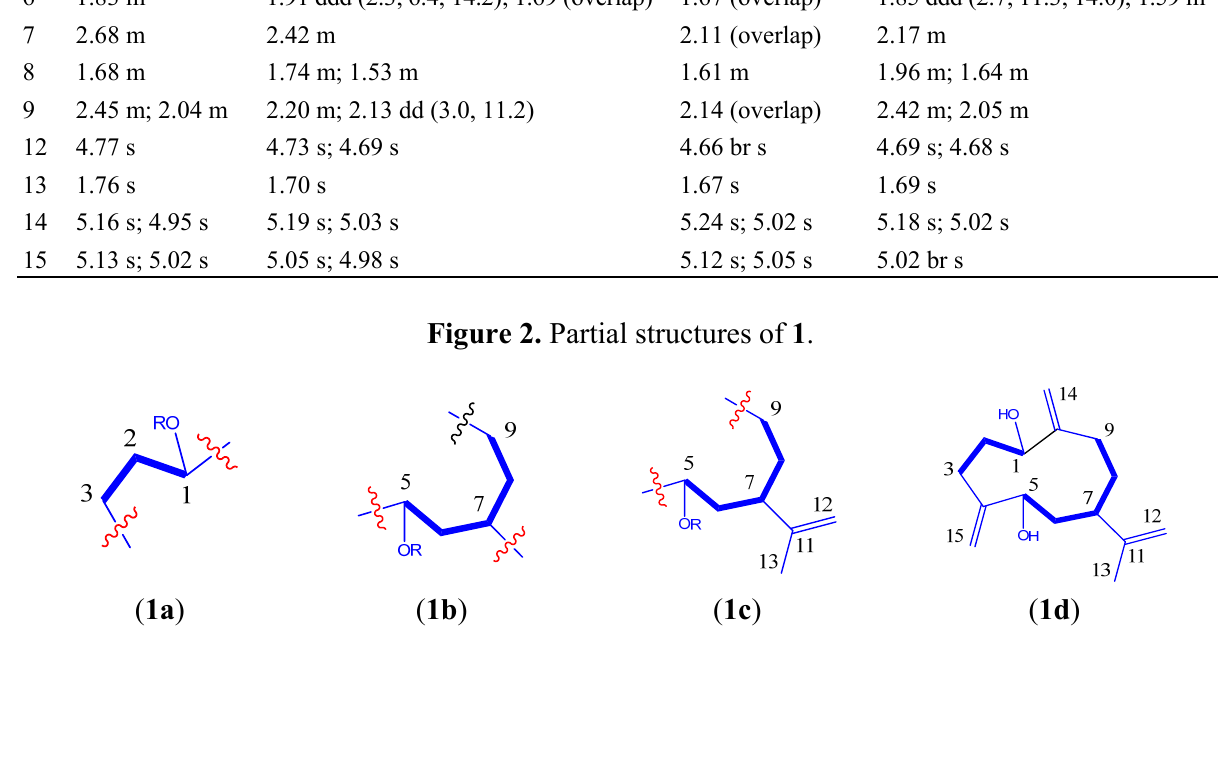
Table 2. 1 H-NMR Spectroscopic Data for Compounds 1 – 4 (CD